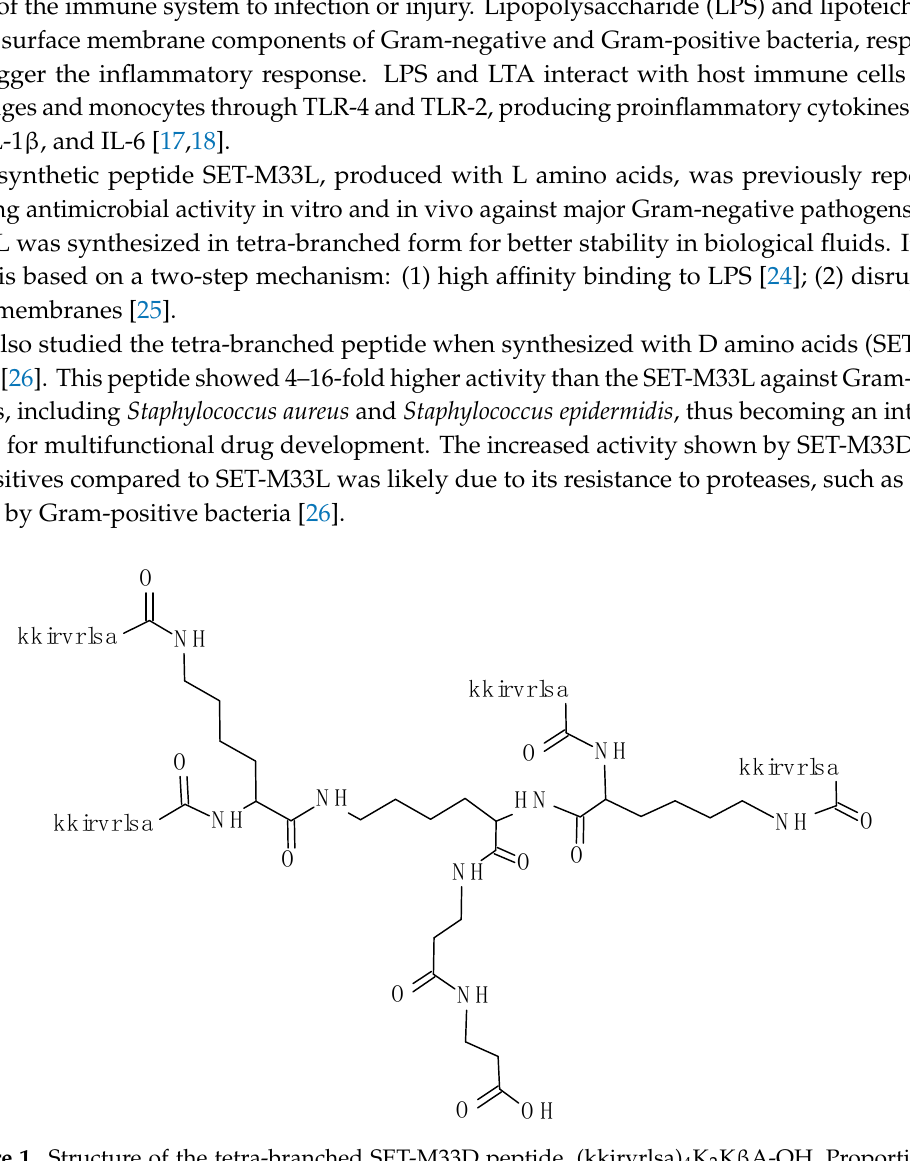
Figure 1. Structure of the tetra-branched SET-M33D peptide, (kkirvrlsa) 4 K 2 K β A-OH. Proportions between amino acids in the peptide sequences and the lysine core are not respected.